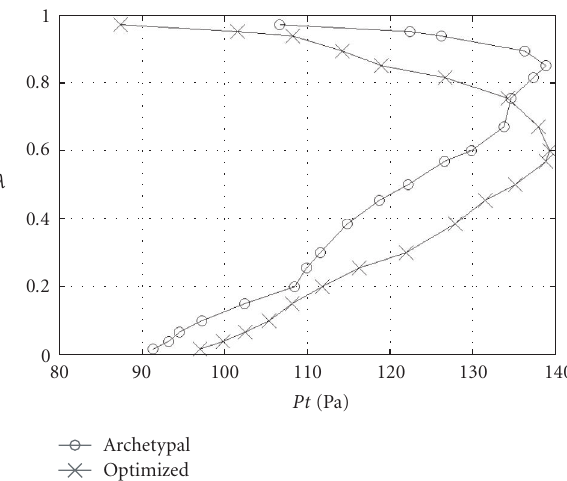
Figure 12: one-third octave spectrum.